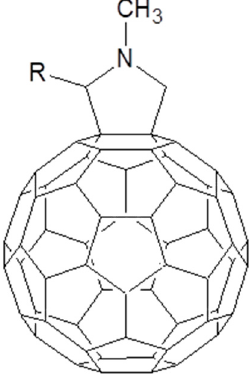
Figure 12. C 60 fulleropyrrolidine chemical structure.